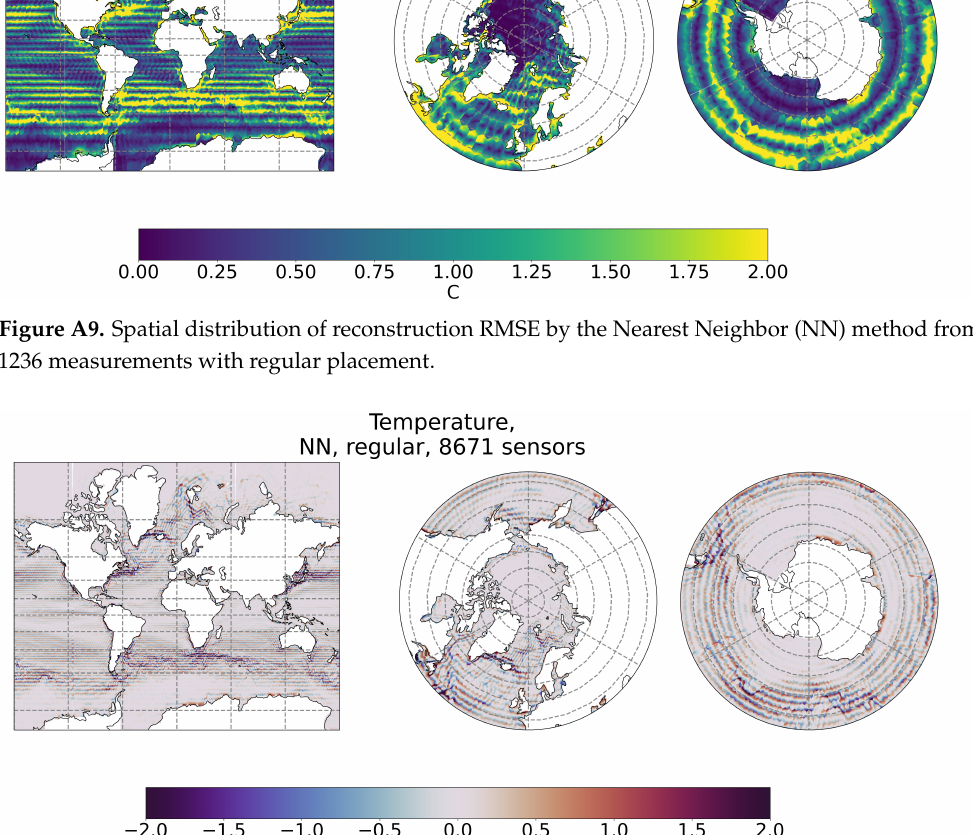
Figure A10. Spatial distribution of reconstruction bias by the Nearest Neighbor (NN) method from 8671 measurements with regular